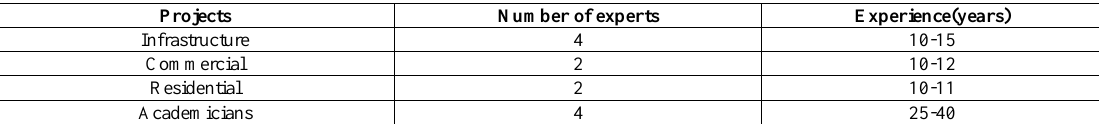
Table 1. Demographic profile of